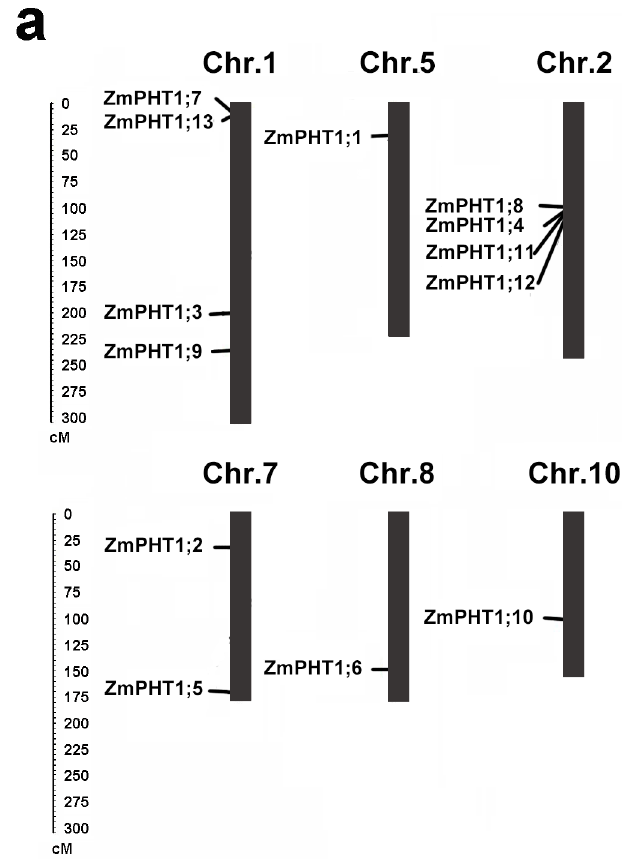
Figure 3. Cont. Figure 3.